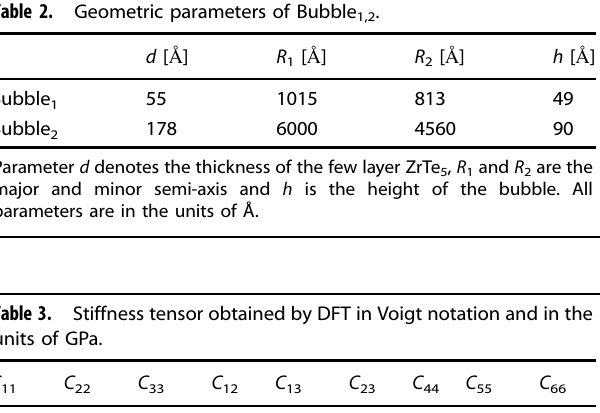
Table 2. Geometric parameters of Bubble 1,2 .